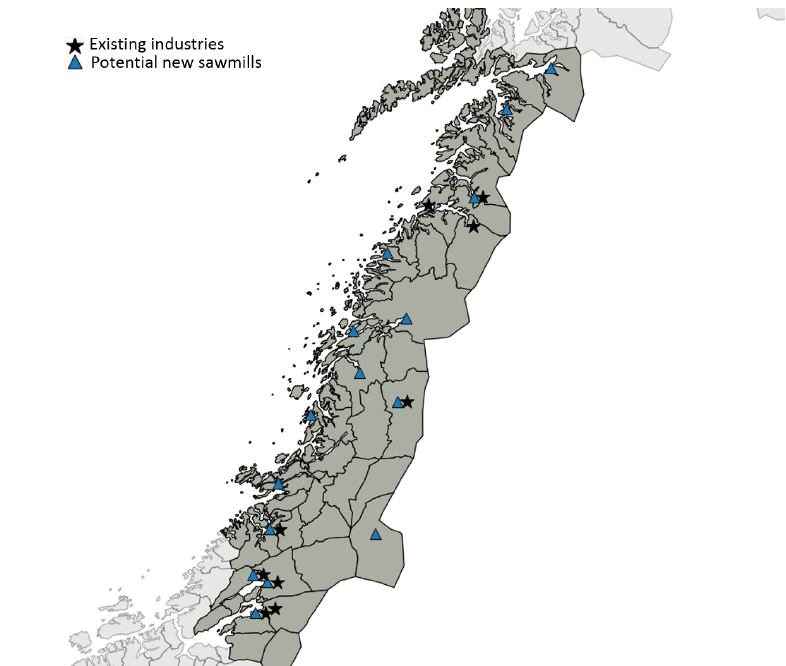
Figure 3. The northern Norwegian region considered in the case, with municipality borders. Map drawn using QGIS Geographic Information System